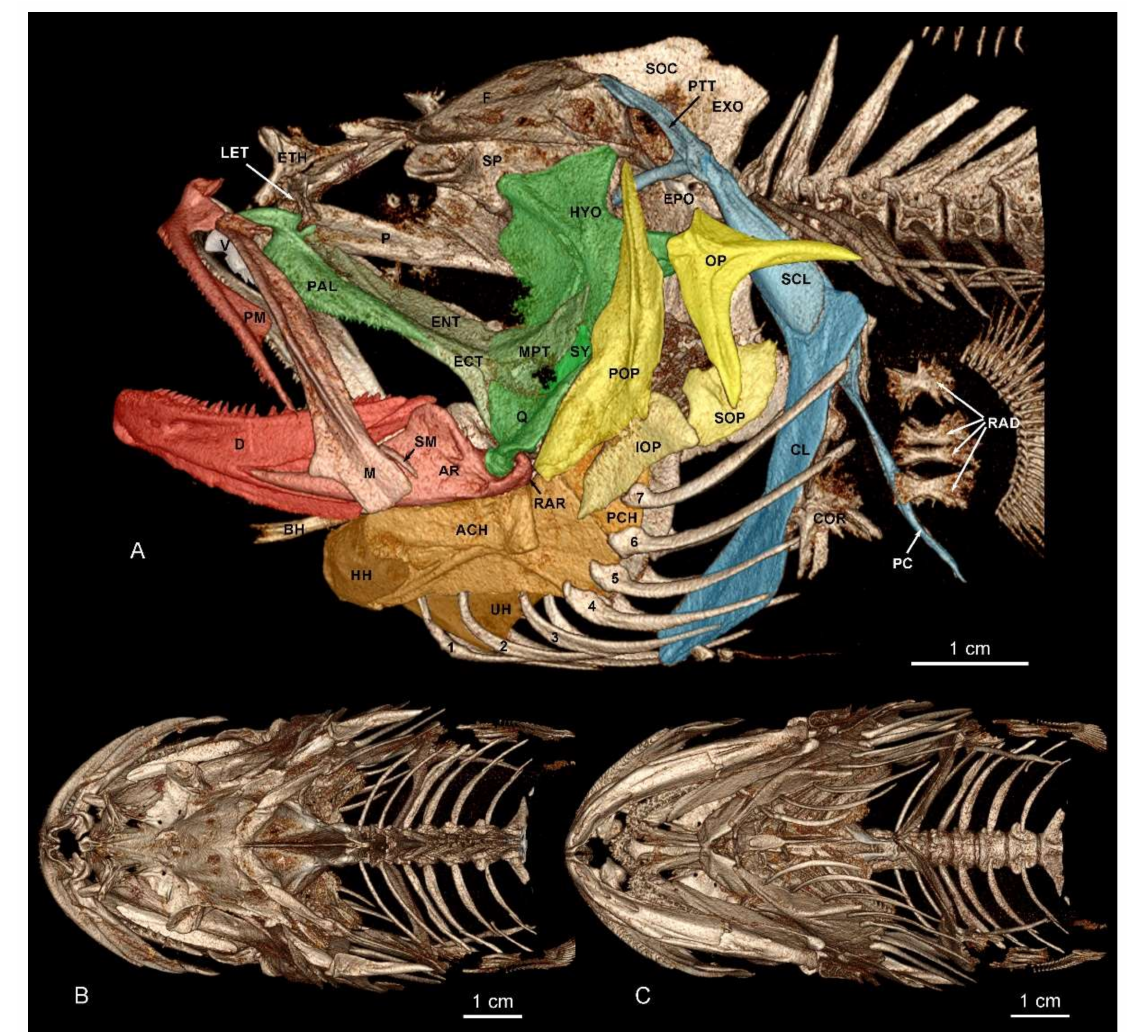
Figure 2. Bidenichthys okamotoi n. sp. CT scans of the skull of the holotype, ZMUC P2397717, ( A ), lateral view, ( B ), dorsal view, ( C ), ventral view; ( A ) is color-coded with acronyms for individual bones as follows: Red = oral jaw, AR = articular, D = dentary, M = maxilla, PM = premaxilla, RAR = retroarticular, SM = supramaxilla; Green =